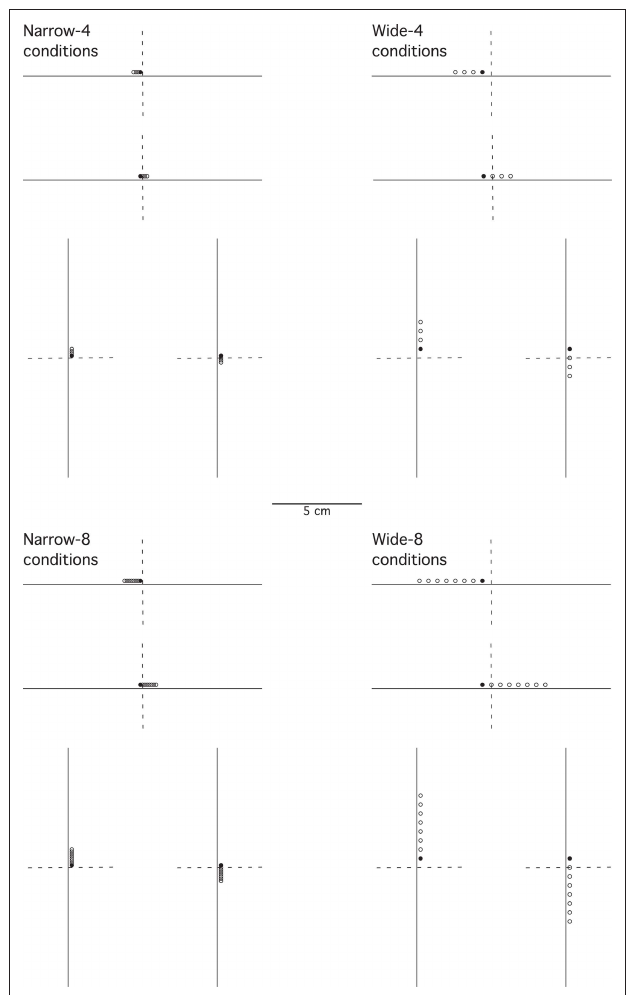
Figure 1 | An illustration of the stimulus locations presented for the task in half the set ups used in the experiments. The dashed vertical or horizontal lines indicate the center, a line not shown to participants in the experiments. The location closest to the center, a filled dot, is the target (S + ); the other locations shown as open dots are test locations. Shown are conditions in which the target is just to the left of center along the horizontal line, or just above the center along the vertical line. The other set ups have targets just to the right of center along the horizontal line, or just below the center along the vertical line, forming mirror images of the locations shown in the